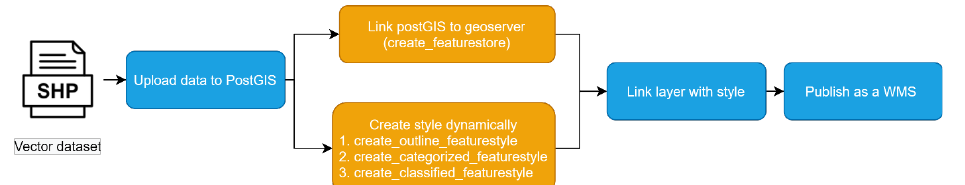
Figure 3. workflow for publishing the WMS standard for vector